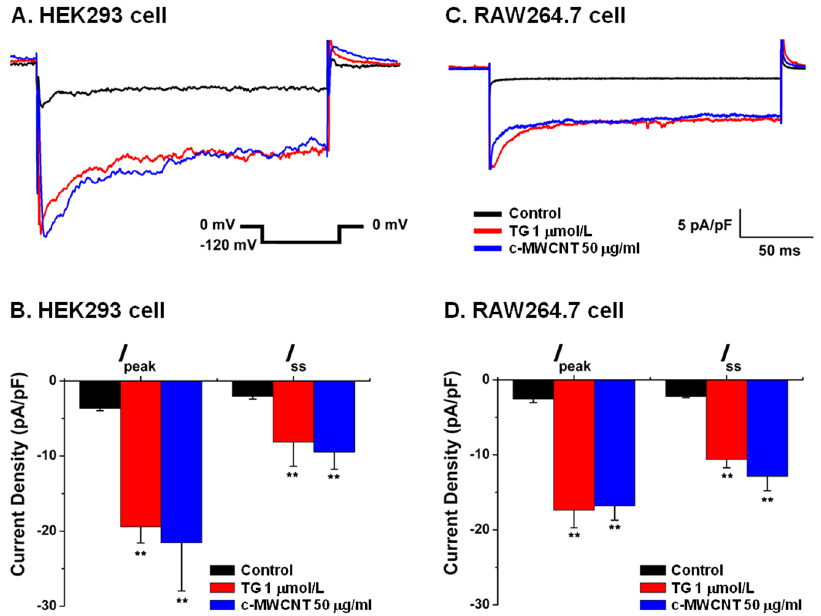
Figure 2. Whole-cell recordings of the CRAC currents ( I CRAC ) in different cells. ( A and B ) A representative I CRAC and the statistical analyses of the I CRAC densities including I peak (peak currents) and I ss (steady-state currents) in HEK293 cells stably expressing Orai1 and STIM1. ( C and D ) A representative I CRAC and the statistical I CRAC densities of I peak and I ss in RAW264.7 cells. Note that both c-MWCNTs and TG significantly increased the I CRAC densities in the two cell lines. ** P < 0.01 vs . control. N = 5 (cells) in each group. TG,